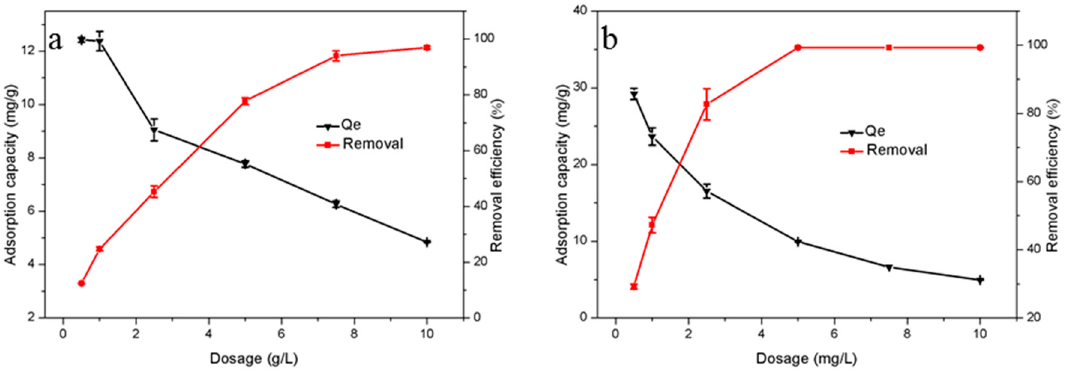
Figure 6. Effect of adsorbent dosage on removal of Cr(VI): ( a ) HTC and ( b ) HTC-NH 2 .